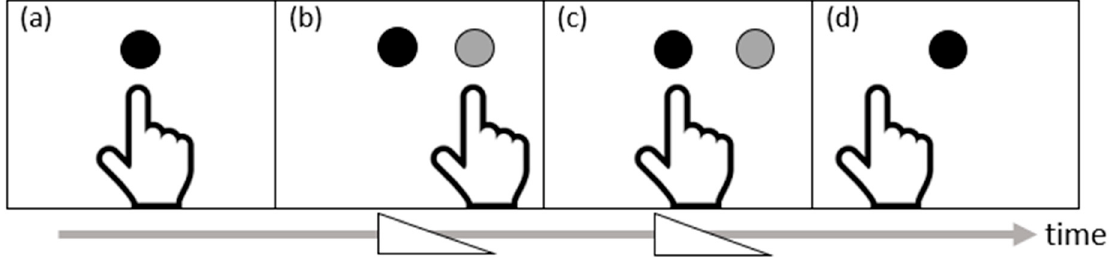
Figure 1. Prism adaptation illusion in four steps: ( a ) Before putting on prism lenses, the hand points to the target. ( b ) When putting on left-based prisms that induce a rightward shift of vision, the hand points to the shifted image instead of the actual target. ( c ) After several pointing attempts, the hand points to the actual target, which is left to the shifted image. This is prism adaptation. ( d ) Once the prism lenses are removed, the hand points to the left of the target. This is an after- effect.